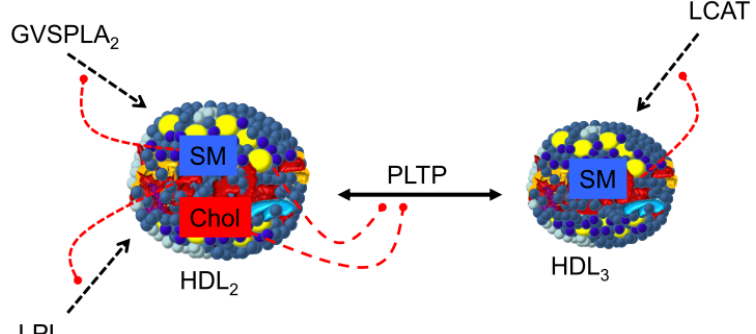
Figure 5. Role of HDL-SM in modulating enzymes of HDL metabolism. SM and cholesterol have been described as inhibitors of PLTP, phospholipid transfer protein.